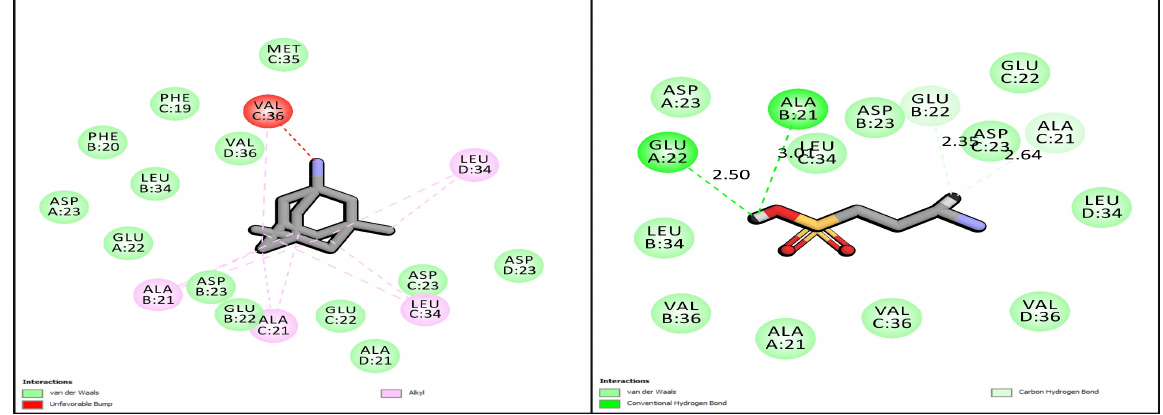
Figure 1. 2D molecular docking simulations of MeHCl and TMPS.